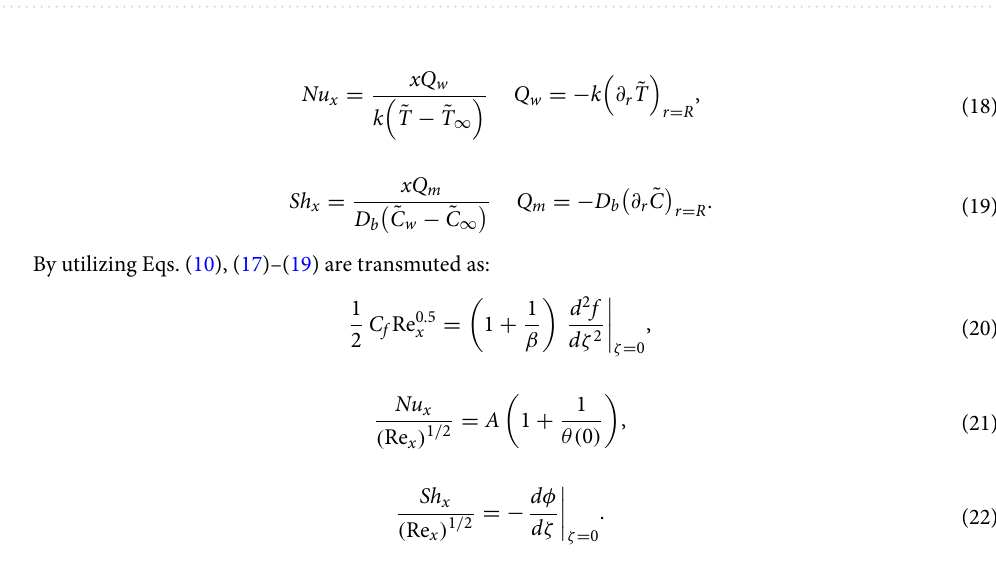
Table 1. Comparison of Nu x Re − 0.5 x for current analysis with Upadhya 6 and Murthy 30